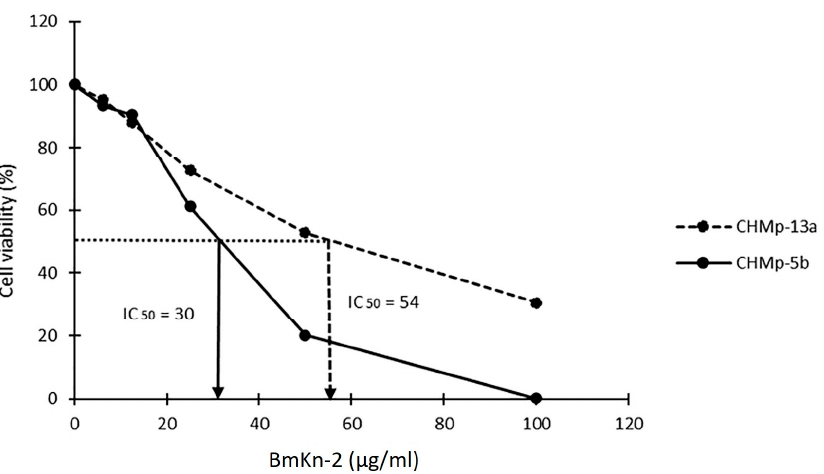
Figure 1. Percentage cell viability in CHMp-5b and CHMp-13a cell lines, treated with BmKn-2 (0–100 µ g/mL) for 24